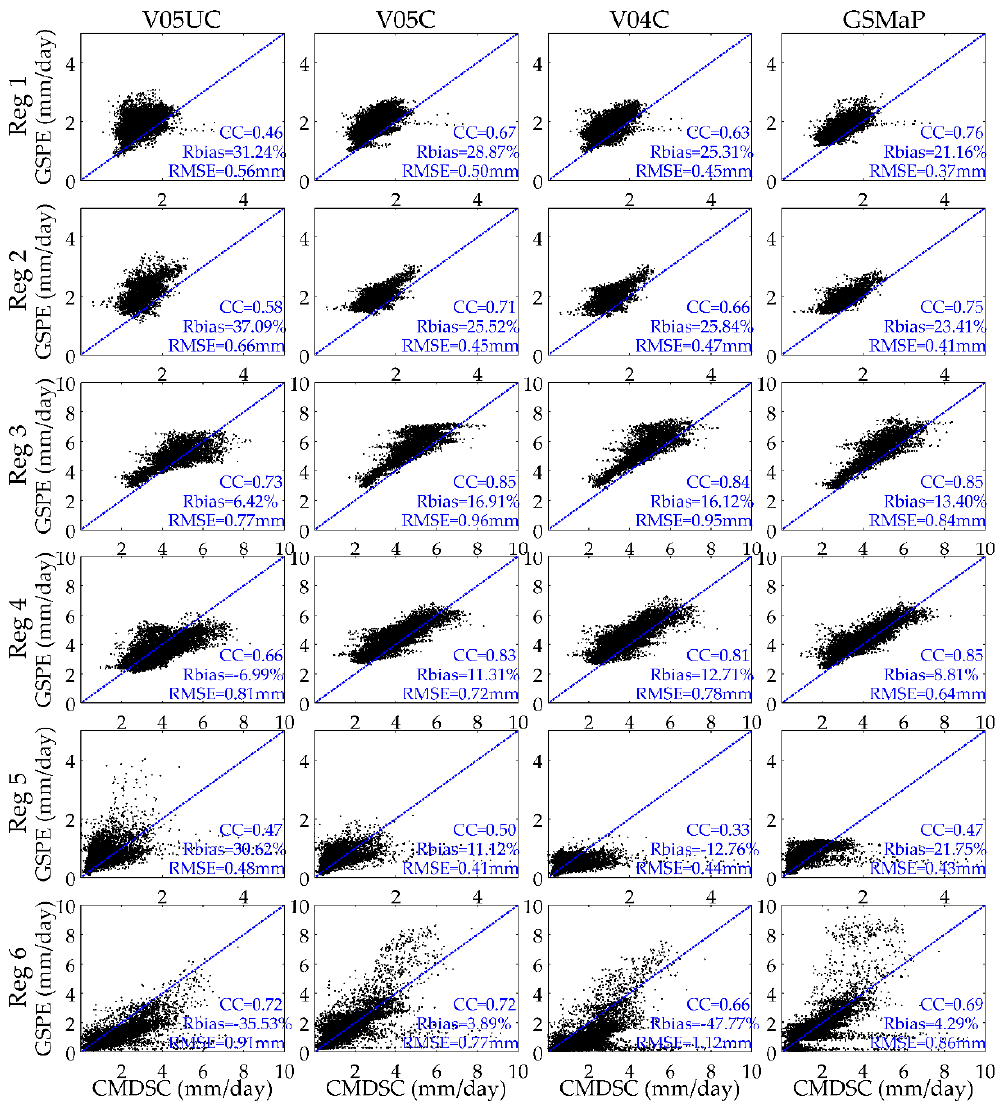
Figure 3. Scatter plots of daily average precipitation (mm/day) for four GSPEs against CMDSC over six selected regions of mainland China during April 2014 and December 2016.